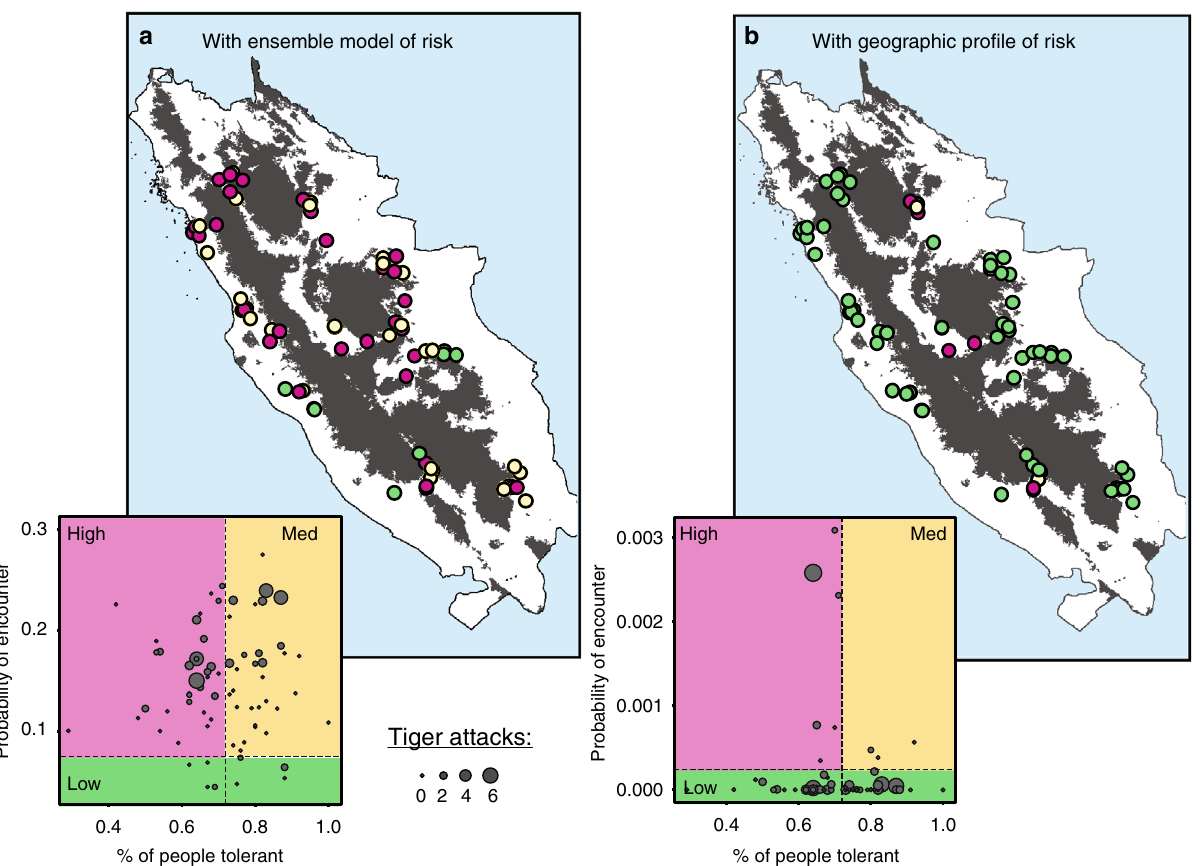
Fig. 3 Prioritisation of villages for tiger con fl ict mitigation efforts using tolerance and risk data. The 75 survey villages are partitioned into high (magenta = above median risk; below median tolerance), medium (beige = above median risk; above median tolerance) and low (green = below median risk) priorities using a an ensemble of binomial risk models, or b a geographic pro fi le. The estimates of encounter risk were based on models utilising all 228 human – tiger encounters; alternative estimates from models using sightings data only provided the same result. Point size is weighted by the number of attacks (on livestock or people) reported in each